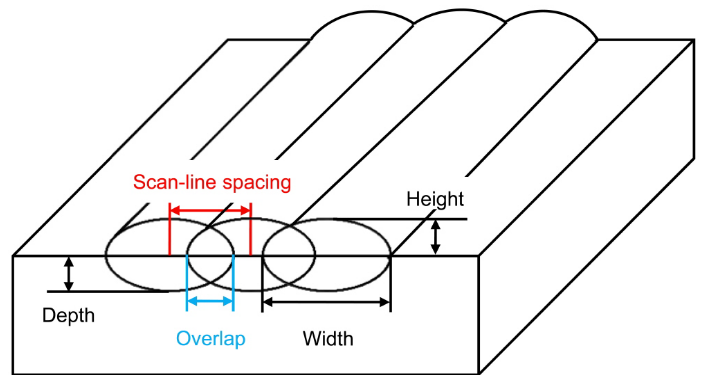
Figure 2. Schematic illustration of the multi ‐ layer formation test.